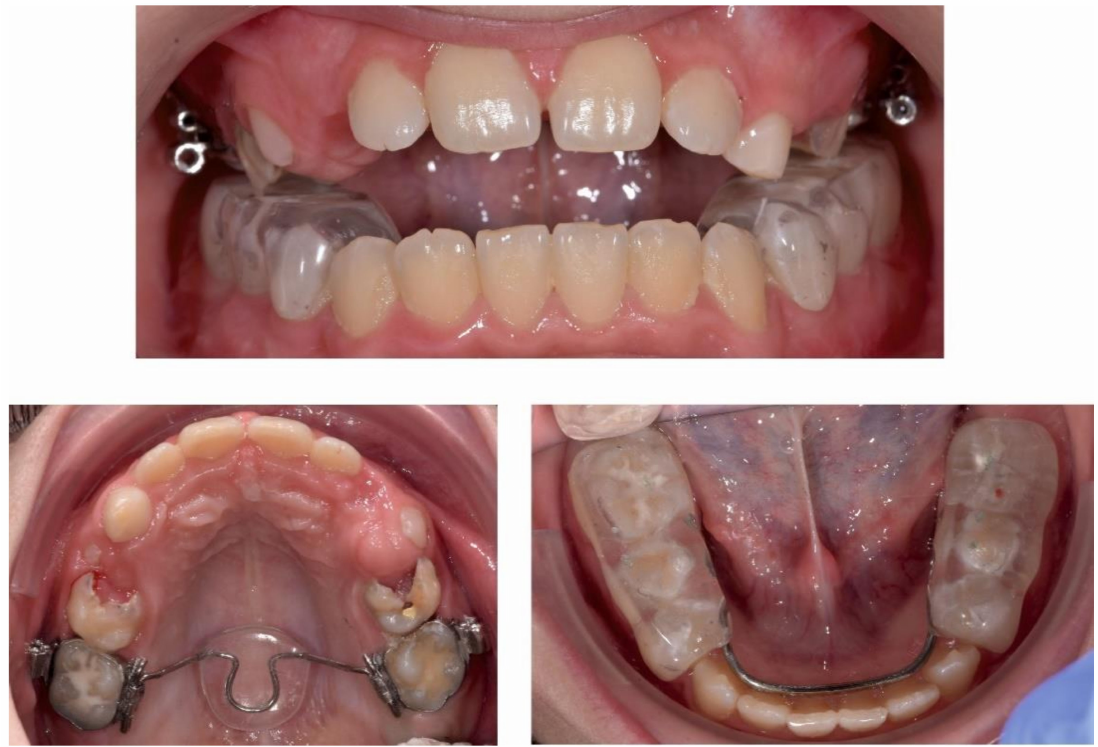
Figure 17. Transpalatal arch with acrylic button and mandibular acrylic splint.